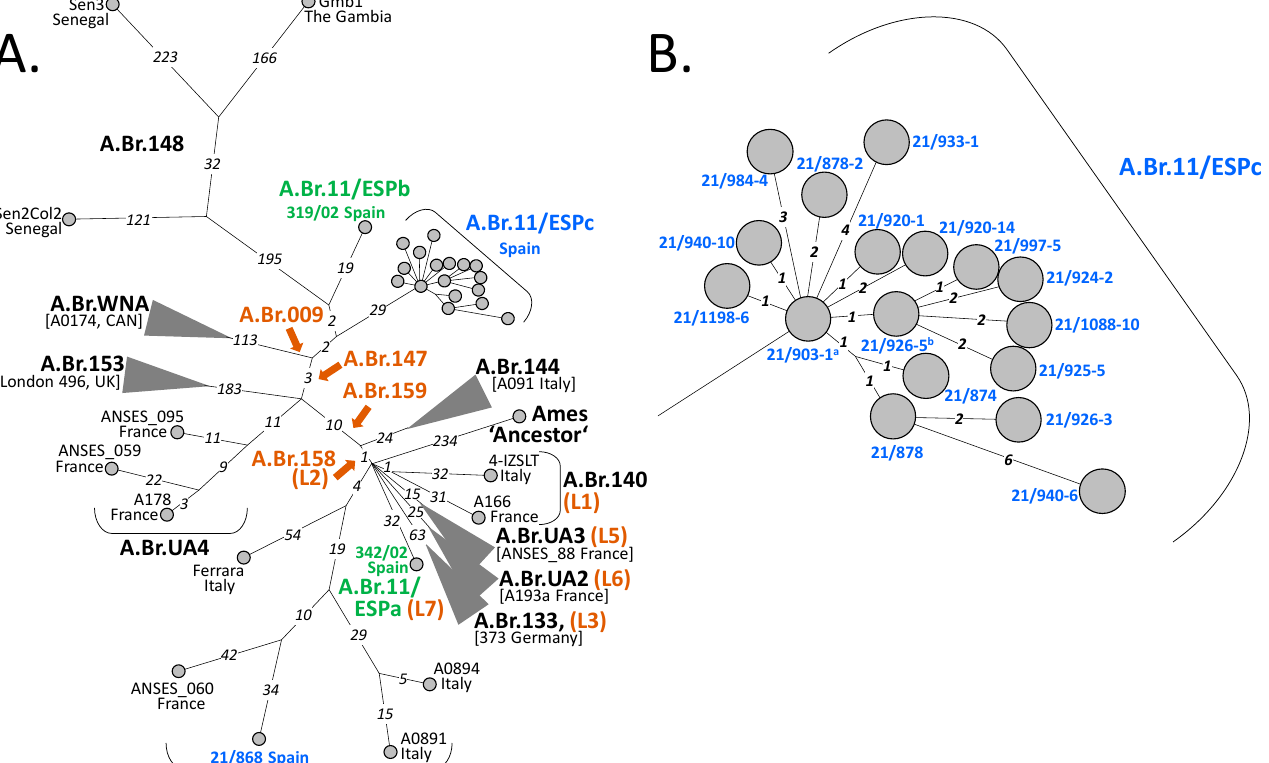
Figure 3. SNP distances between Spanish isolates of B. anthracis and their relatives of the A.Br.011/009 lineage. Minimum spanning trees of Spanish B. anthracis isolates and representative individual relatives with (condensed) clades ( A ) or a close-up of members of clade A.Br.11/ESPc ( B ) are depicted. Shown are numerical SNP distances between chromosomes of isolates from Figure 2. Color-coding of branch names, condensed branches, strains or relevant canSNP positions is the same as in Figure 2. The tree is rooted to the B. anthracis reference strain Ames ‘Ancestor’ (from the A.Br.Ames clade). a identical chromosomal sequence to isolates 21/890-8; 21/890-9; 21/903-6; 21/905-13; 21/918-3; 21/926-9; 21/926-22; 21/940-19; 21/955-9; b identical chromosomal sequence to isolates 21/891-2; 21/1088-3.